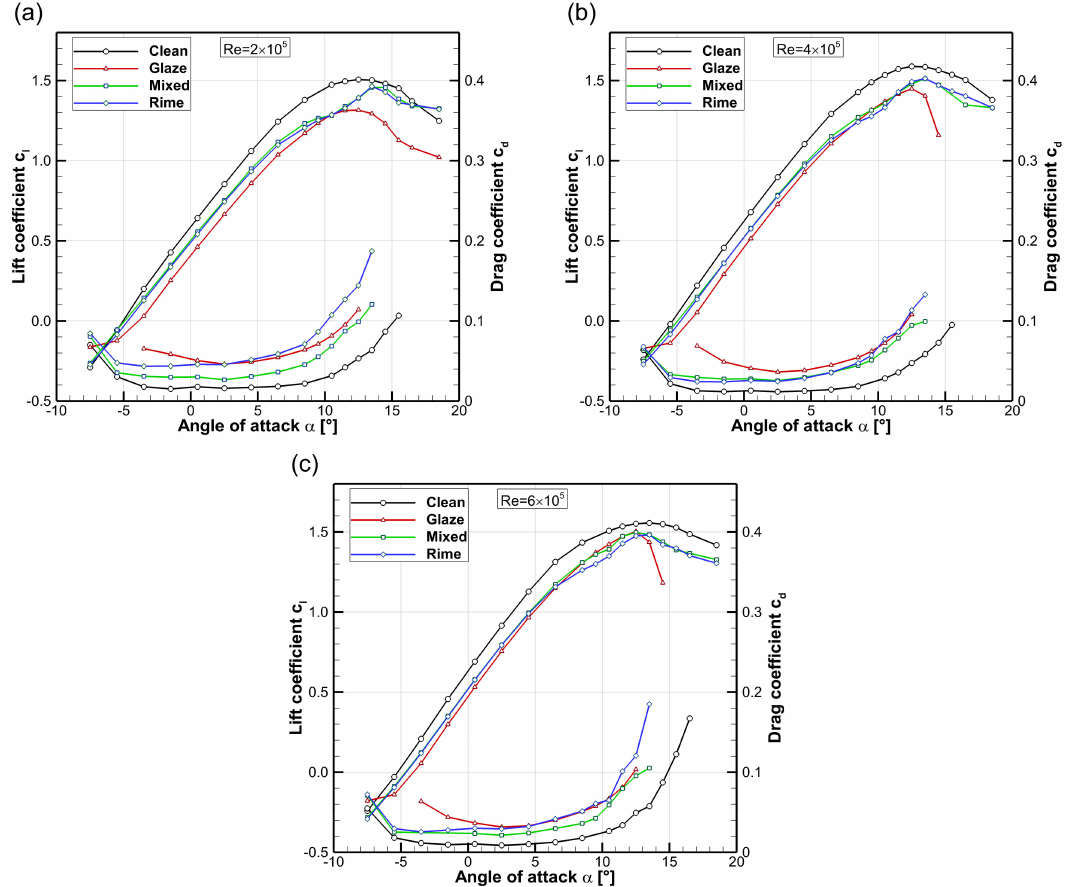
Figure 6. Experimental results for lift and drag of the IWT ice shapes for Re = 2 × 10 5 ( a ), 4 × 10 5 ( b ), and 6 × 10 5 ( c